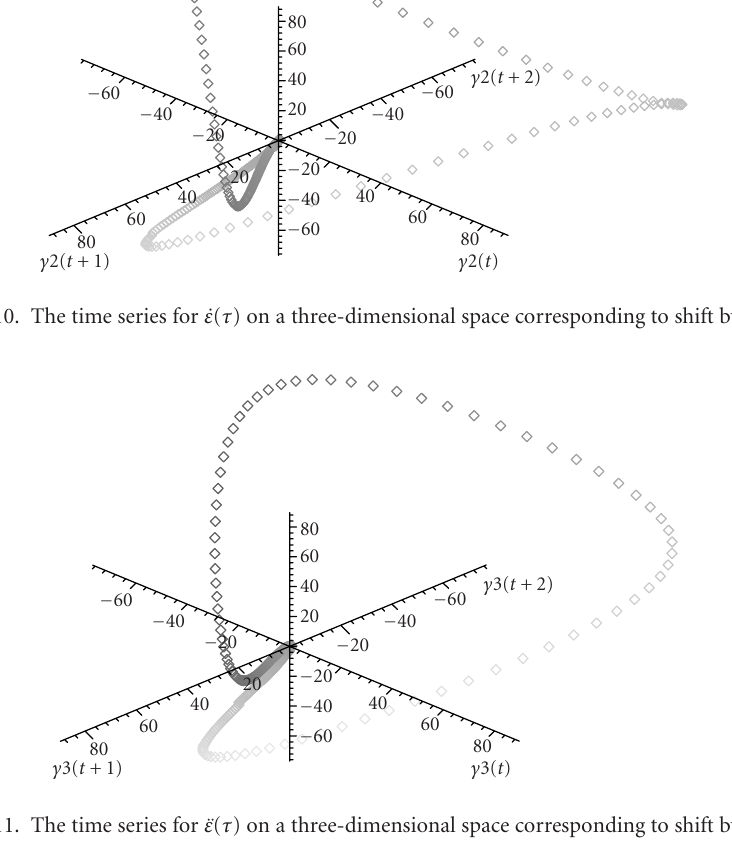
Figure 5.11. The time series for ¨ ε ( τ ) on a three-dimensional space corresponding to shift by 20 time